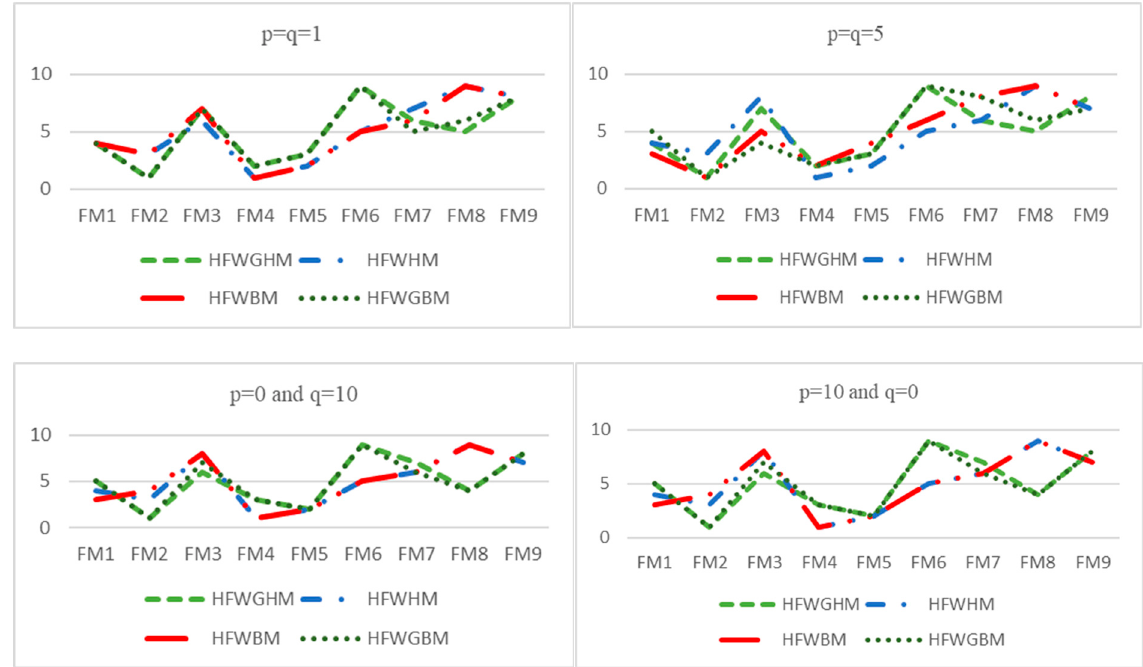
Figure 5. The results of comparison analysis.